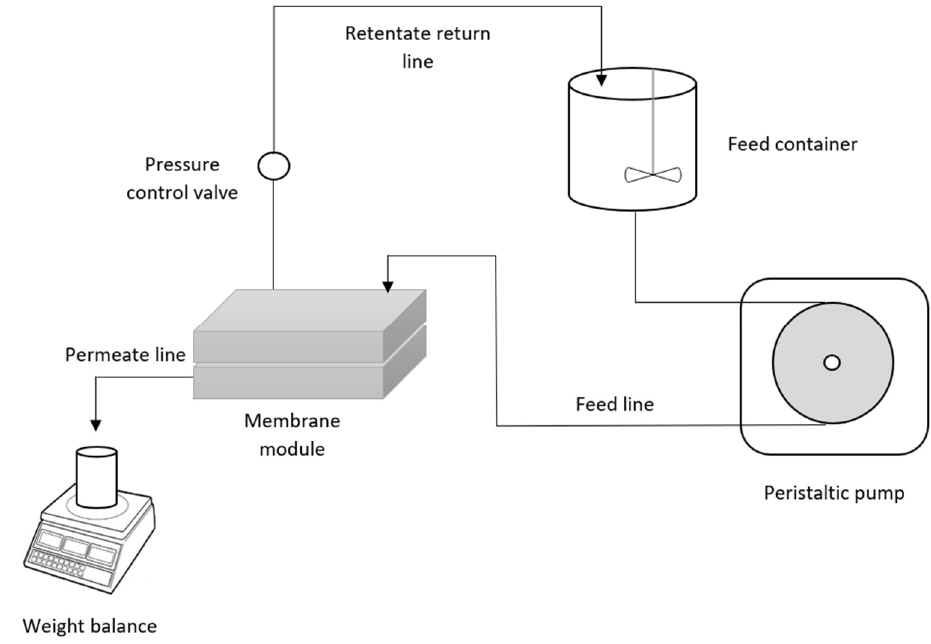
Figure 1. Schematic diagram of the permeation rig.